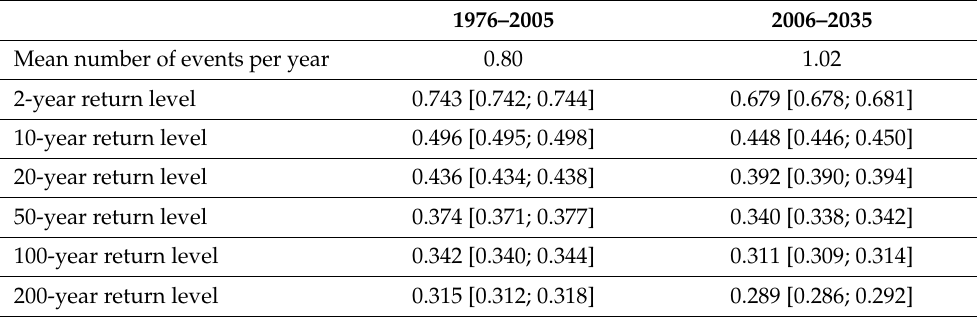
Table 2. Different return levels for low flows for each sub-period with their 70% bootstrap confidence interval in